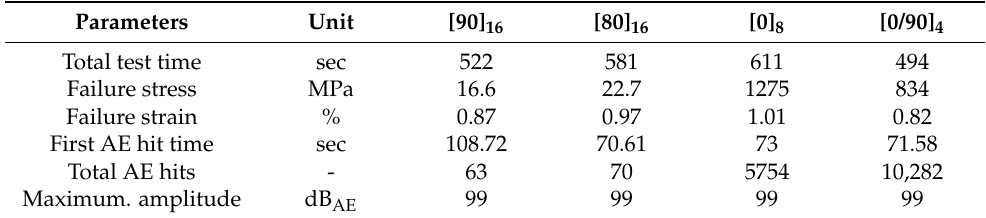
Table 3. Summary of experimental